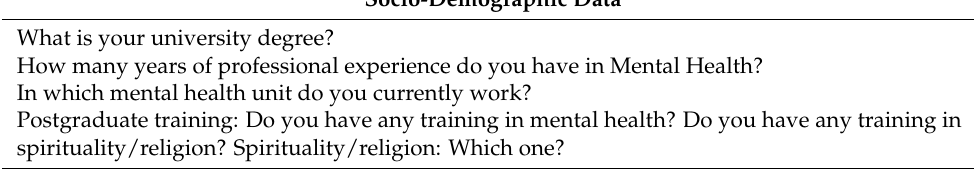
Socio-Demographic Data